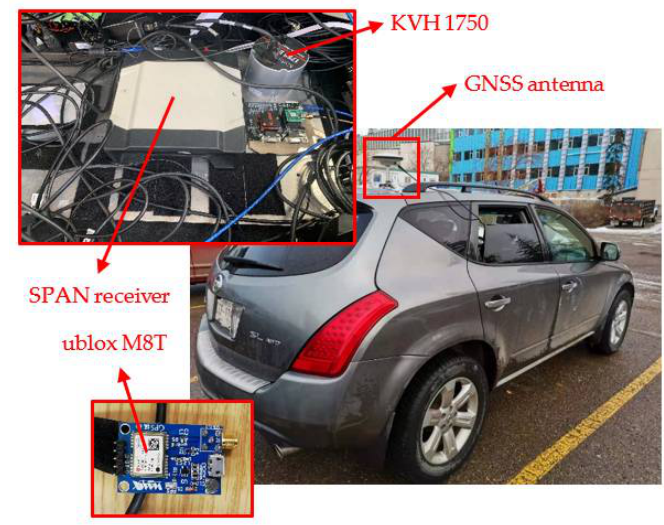
Figure 8. Experimental vehicle and the utilized devices.